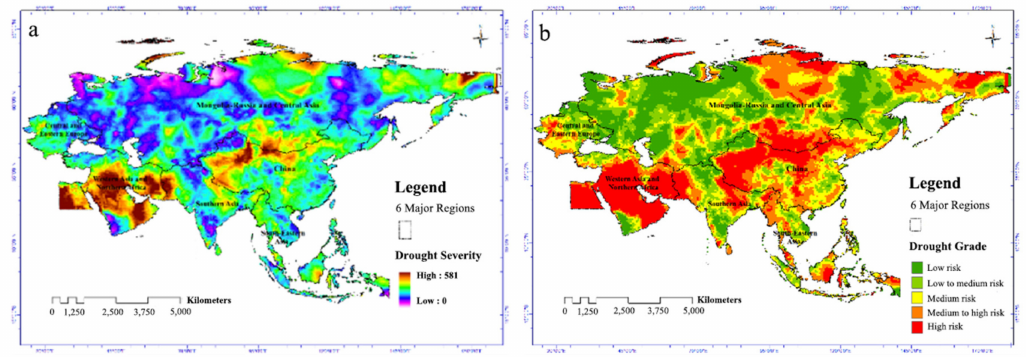
Figure 4. ( a ) drought frequency map along the “Belt and Road” zone; ( b ) drought frequency hierarchical map.